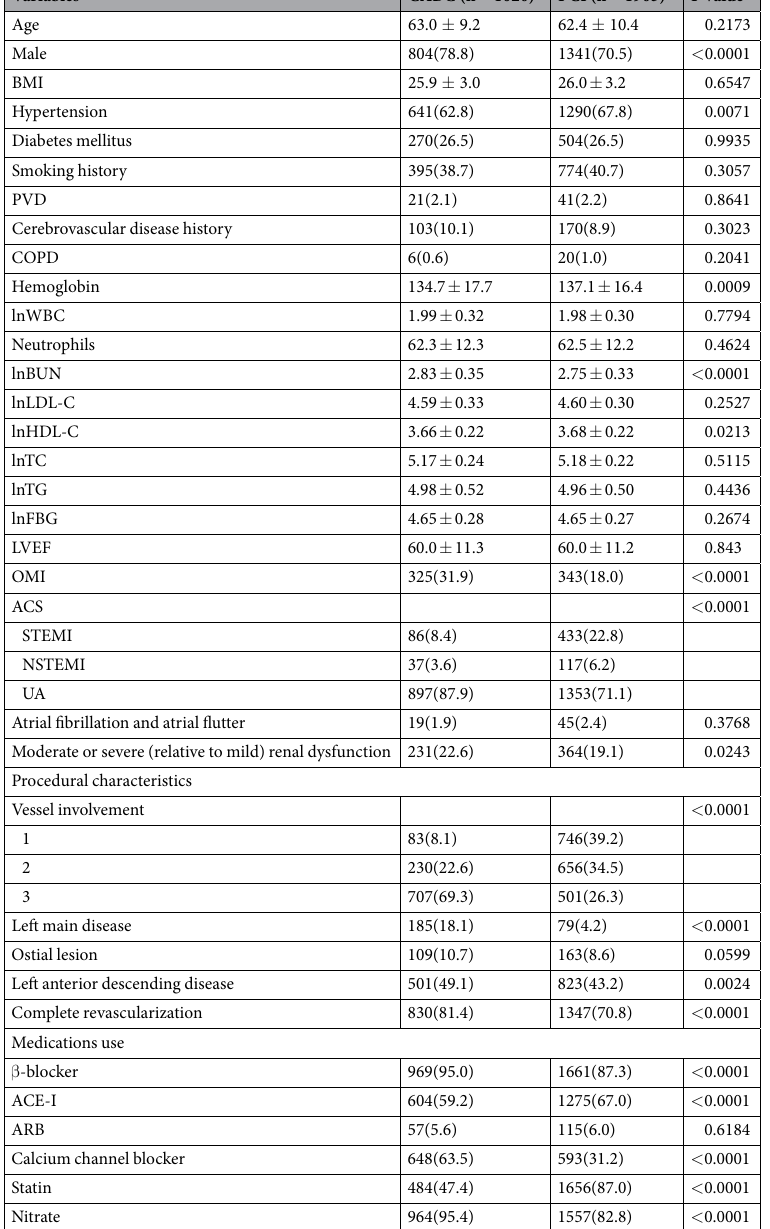
Table 1. Baseline characteristics of ACS patients with renal dysfunction. Mean ± standard deviation,